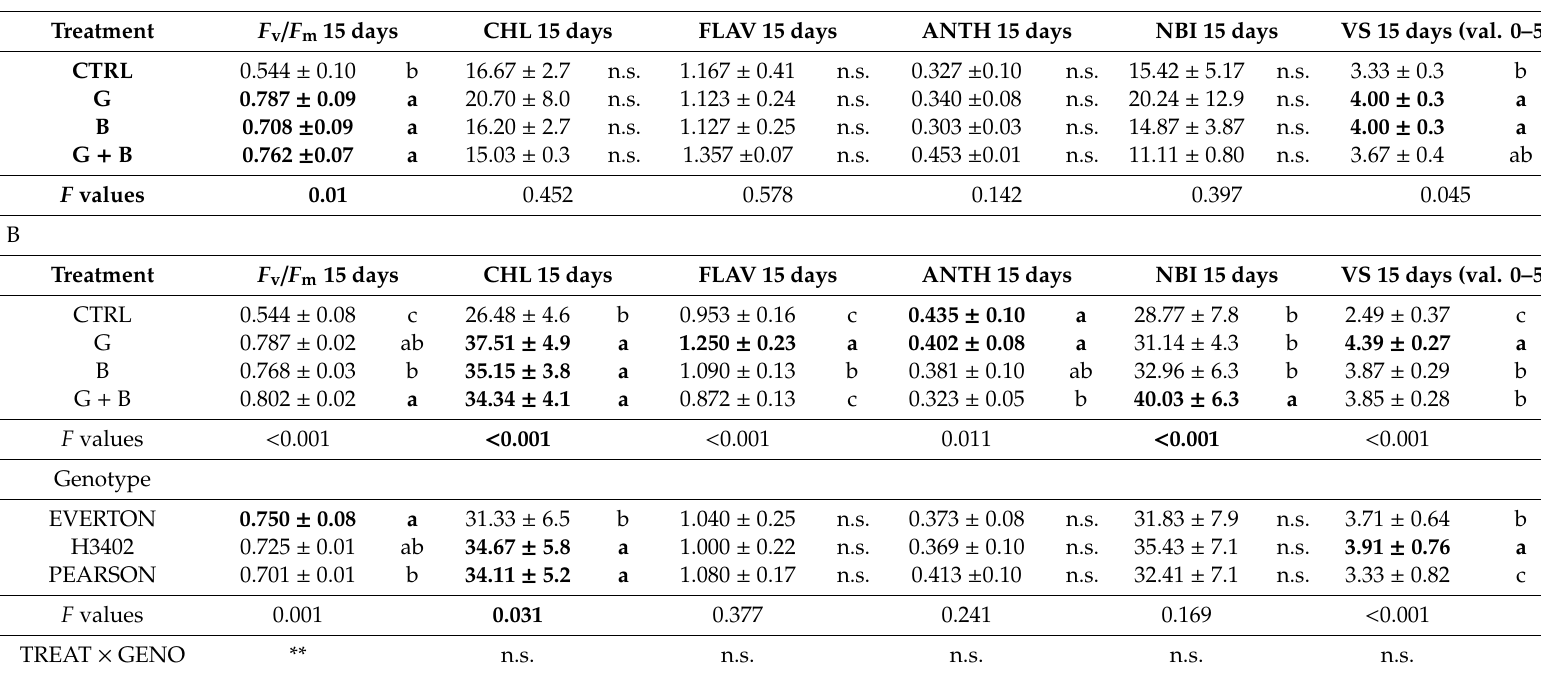
Table 4. Parameters measured 15 days after chilling stress (regrowth) in the first and second experiment ( A and B , respectively). F v / F m = photochemical e ffi ciency of photosystem II (PSII), CHL = index of the chlorophyll content in leaf measured using a DUALX instrument, FLAV = index of the flavonoid content in leaf measured using a DUALX instrument, ANTH = index of the anthocyanin content in leaf measured using a DUALX instrument, NBI = nitrogen balance index, VS 15 days = visual score recorded, 15 days = measured or recorded at regrowth (15 days after stress), CTRL = seedlings without microorganism treatment, G = seedlings inoculated with Funneliformis mosseae , B = seedlings inoculated with Paraburkholderia graminis , G + B = seedlings inoculated with Funneliformis mosseae + Paraburkholderia graminis , TREAT = treatment, GENO = genotype. Data are presented as mean ± standard deviation (SD) (in the first experiment n = 5; in the second experiments n treatment = 15 and n genotype = 20). Di ff erent letters indicate statistically significant di ff erences among treatments or genotypes by ANOVA followed by Duncan’s test at p < 0.05, n.s. = not significant, ** = p < 0.01, * = p < 0.05. Bold fonts indicate higher